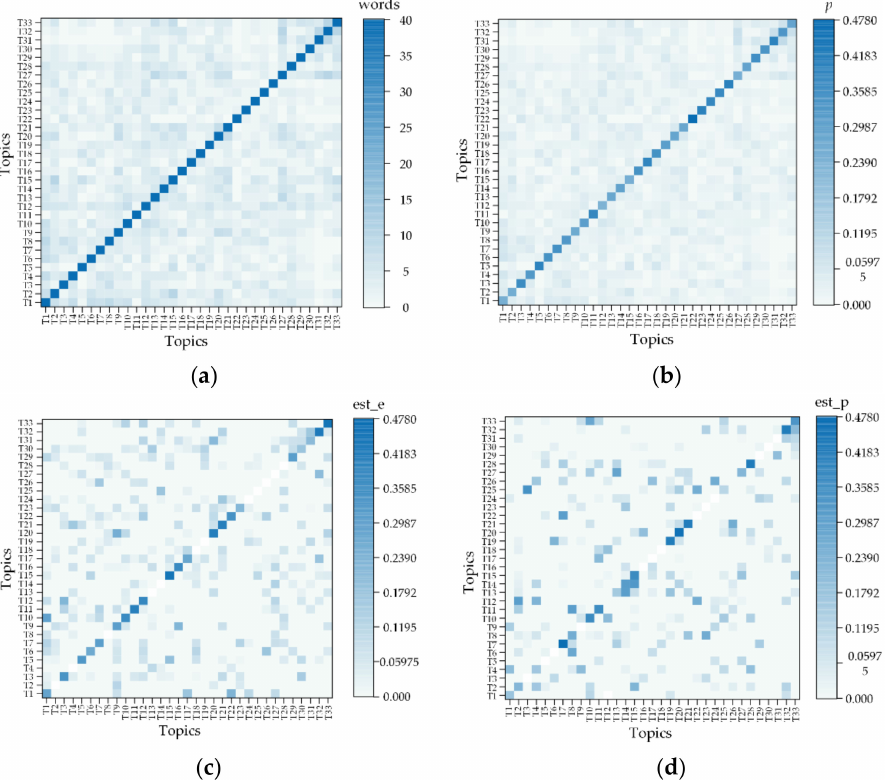
Figure 7. HMM training process. ( a ) Keywords co-occurrence matrix; ( b ) Initial confusion/transition matrix; ( c ) Confusion matrix estimated by HMM; ( d ) Transition matrix estimated by